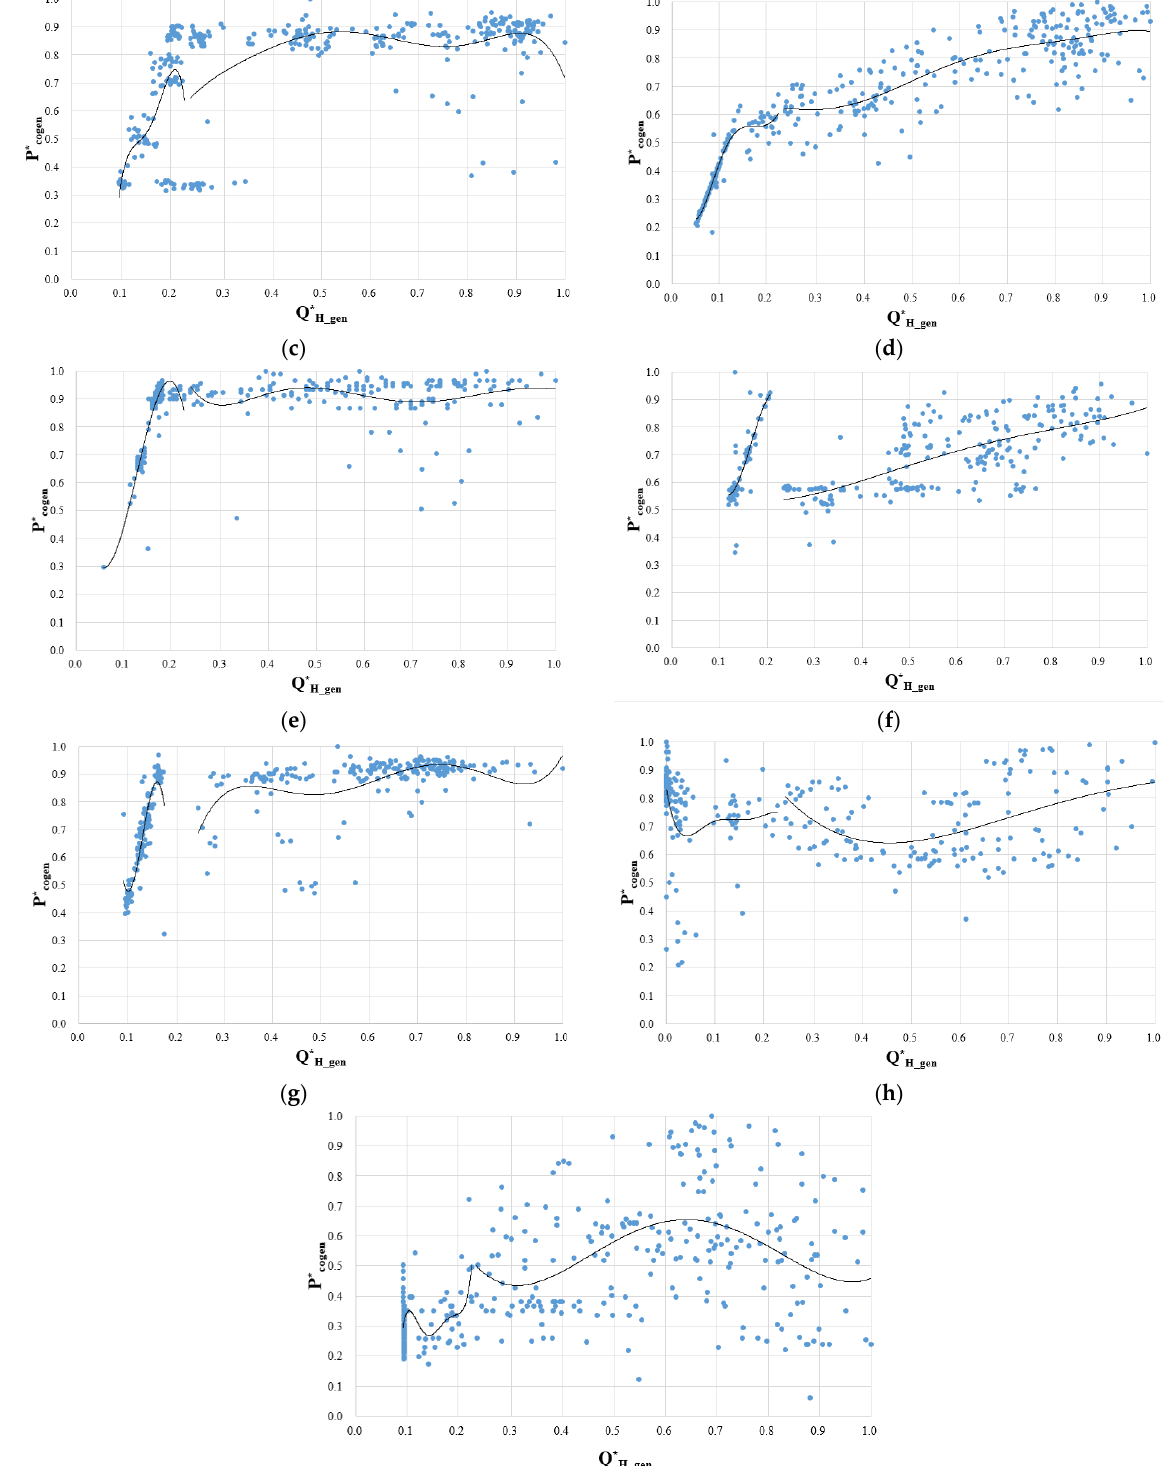
Figure 18. Status of the relationship between the main operating variables for the cases. ( a ) Case